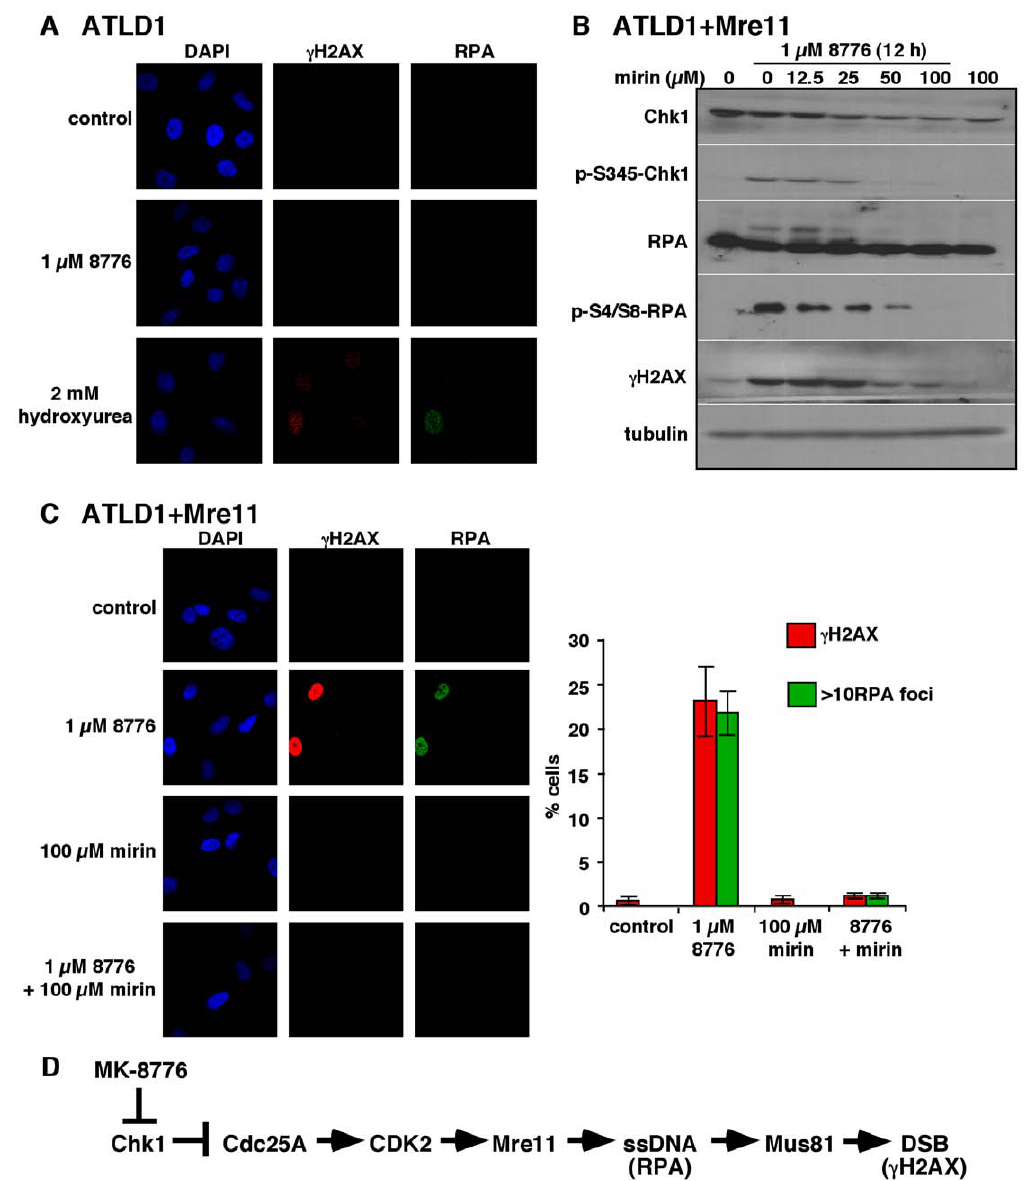
Figure 5. ATLD1 cells do not form RPA or c H2AX foci in response to MK-8776. A. Cells grown on coverslips were incubated with 1 m M MK- 8776 for 6 h, or 2 mM hydroxyurea for 24 h, stained with antibodies against c H2AX and RPA and analyzed by confocal microscopy. B. ATLD1 + Mre11 cells were incubated with 1 m M MK-8776 for 12 h concurrent with 0–100 m M mirin. Cells were harvested and analyzed by western blotting. C. ATLD1 + Mre11 cells grown on coverslips were incubated for 6 h with 1 m M MK-8776, 100 m M mirin or both and analyzed by confocal microscopy for c H2AX and RPA foci. 100 cells were scored for each condition and are presented as histograms on the right. D. Proposed pathway for the induction of damage upon inhibition of